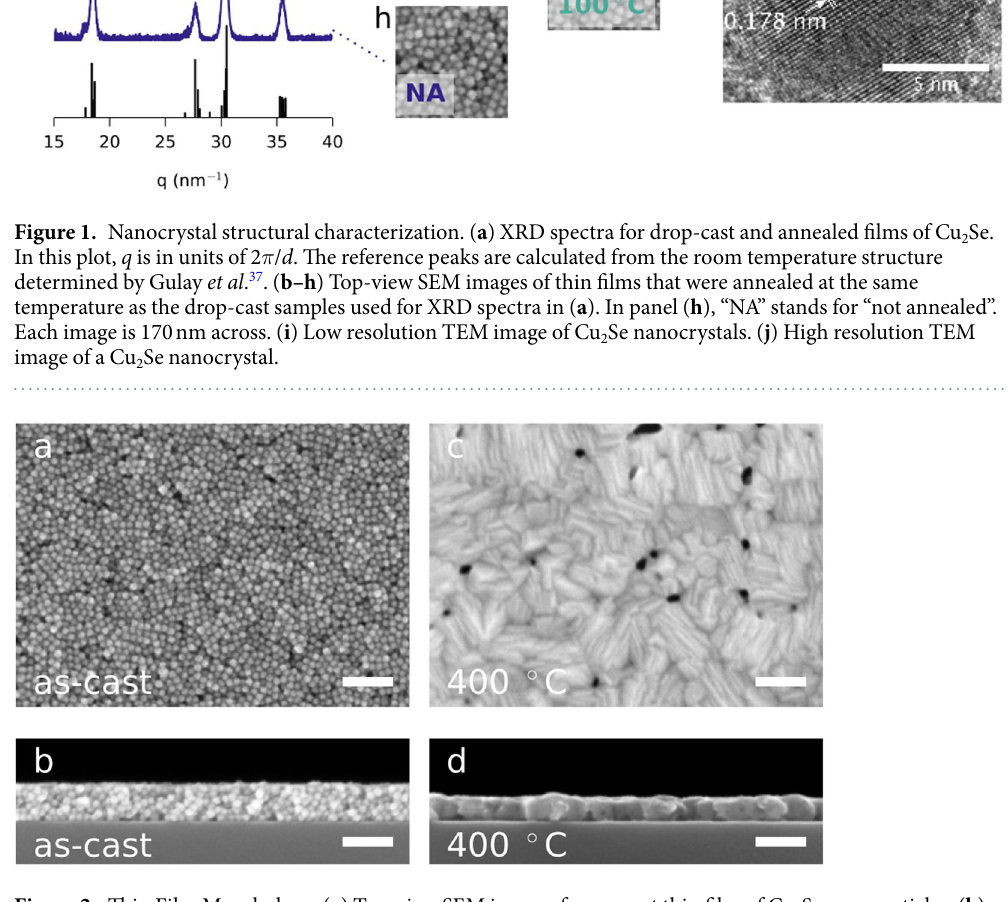
Figure 2. Thin Film Morphology. ( a ) Top-view SEM image of an as-cast thin film of Cu 2 Se nanoparticles. ( b ) Cross-section SEM image of the film shown in ( a ). The film is 75 nm thick. ( c ) Top-view SEM image of a Cu 2 Se thin film after annealing at 400 °C for 45 minutes in an N 2 atmosphere. Prior to annealing, this film was prepared the same way as the film in ( a ). ( d ) Cross-section SEM image of the film shown in ( c ). The film is 54 nm thick. The scale bars in all images are 100 nm wide. The full sets of top-view and cross-section SEM images are shown in Supplementary Figures 2 and